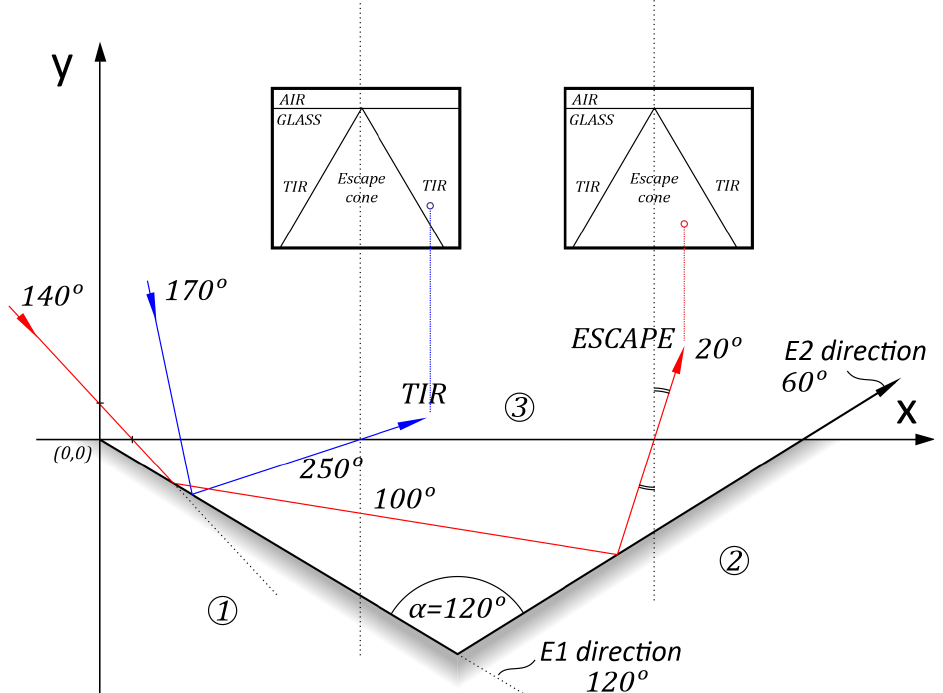
Figure 4. Illustration for ray tracing simulation—example for pitch angle 120 ◦ . 1, 2 reflecting planes, 3—entry/escape plane.